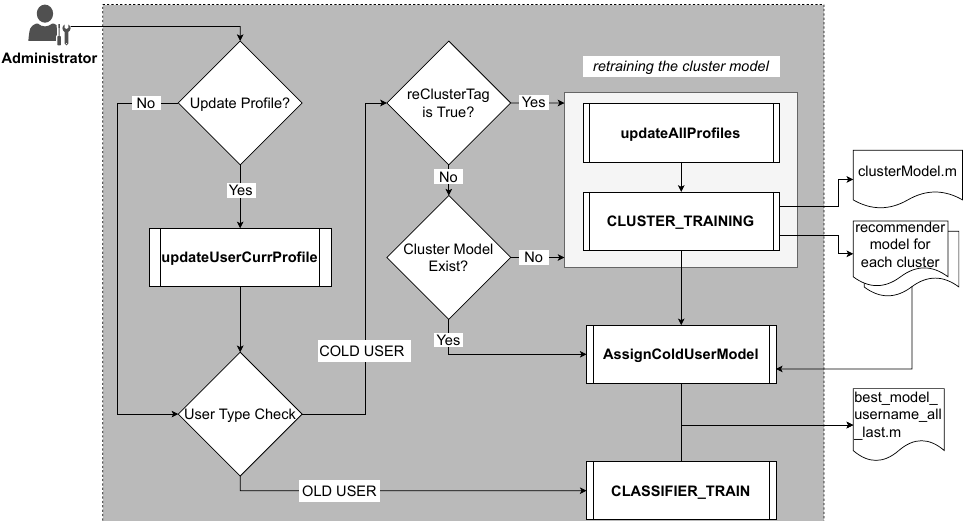
Figure 2. THOR’s Training (Learning)